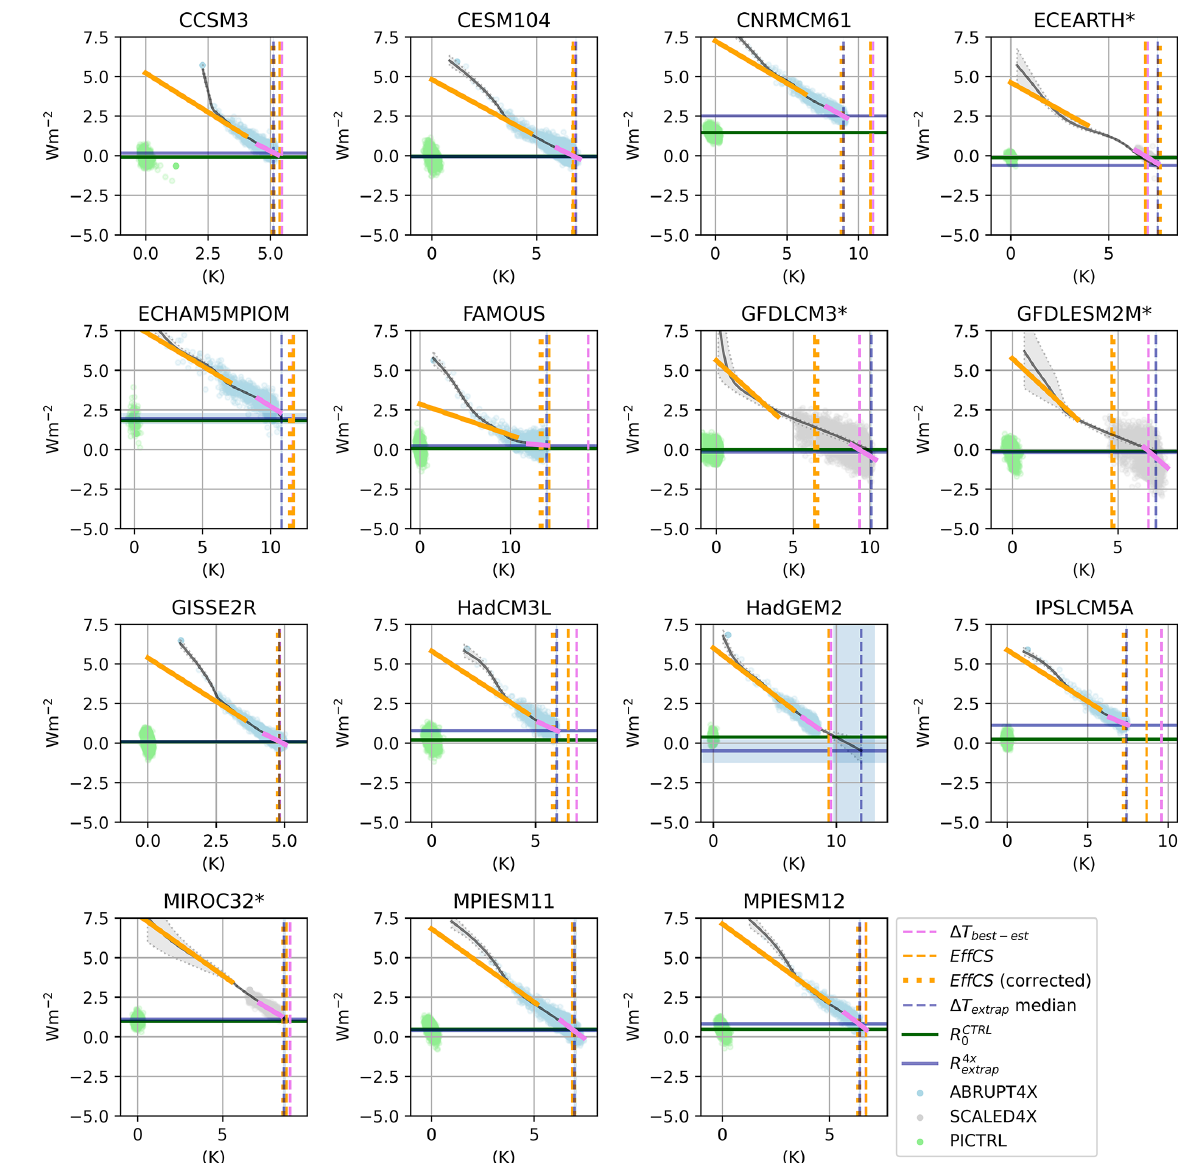
Figure 3. Global mean net radiative imbalance as a function of surface temperature for different members of the LongRunMIP archive. Verti- cal axis shows absolute top-of-atmosphere net radiative imbalance; horizontal axis shows surface temperature relative to the final 500 years of the control simulation. Models marked “ ∗ ” did not provide ABRUPT4X directly (see Table 3). Solid black lines show the median simulation of ABRUPT4X for the fitted MCMC posterior of the multi-timescale model; shaded gray areas show 5%–95% confidence intervals. Light blue points are individual years from ABRUPT4X (if available). For ∗ models, gray points show years in the latter portion of the simulation after which forcing is constant, scaled according to Table 3. Light green points are annual means from PICTRL. Yellow solid line shows the regression fit in years 0–150 for the original ABRUPT4X data if available (or simulated ABRUPT4X median model for models marked “ ∗ ”), corresponding to the EffCS dashed yellow vertical line and EffCS (corrected) dotted yellow vertical line. Purple solid line shows regression fit to the last 15% of warming following Rugenstein et al. (2020), corresponding to the (cid:49)T best − est vertical dashed line. Horizontal green line shows PICTRL net energy imbalance averaged over the final 500 years of the simulation. Horizontal solid blue line shows R 4 x extrap , while vertical dashed blue line shows (cid:49)T extrap ; shaded areas illustrate uncertainty in these